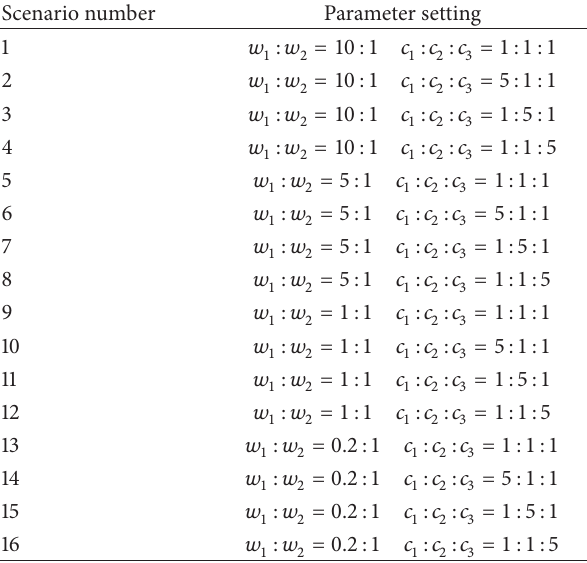
Table 3: Weighting parameters. The numerical values shown are relative weights for the ease of presentation and interpretation. The actual weights used in the model satisfy (13) and (14).